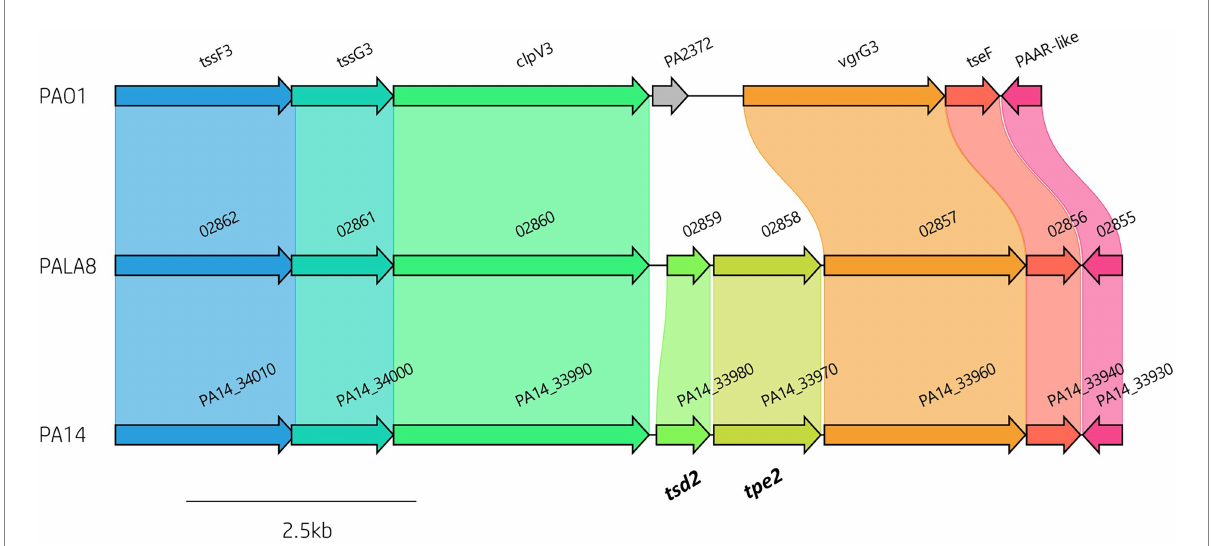
FIGURE 3 Comparative visualisation of the H3-T6SS cluster in PAO1, PA14 and PALA8 showing genomic differences in putative effector gene complement. The H3-T6SS cluster in PA14 and PALA8 contains tsd2 that encodes a predicted cytidine deaminase effector and tpe2 that encodes a predicted type VI peptidase